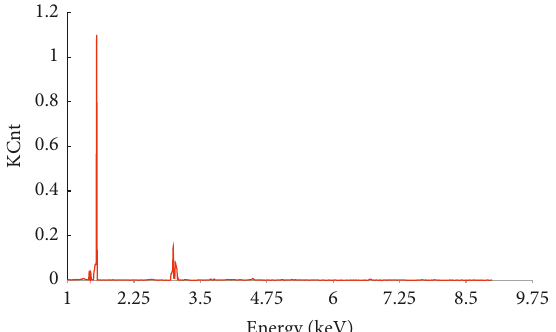
Figure 7: EDX spectra of obtained silver nanoparticles ( S (Ag + ) � 1.0mmol/L, τ � 10min, and ratio AgNO 3 :extract (mL) � 1:1).